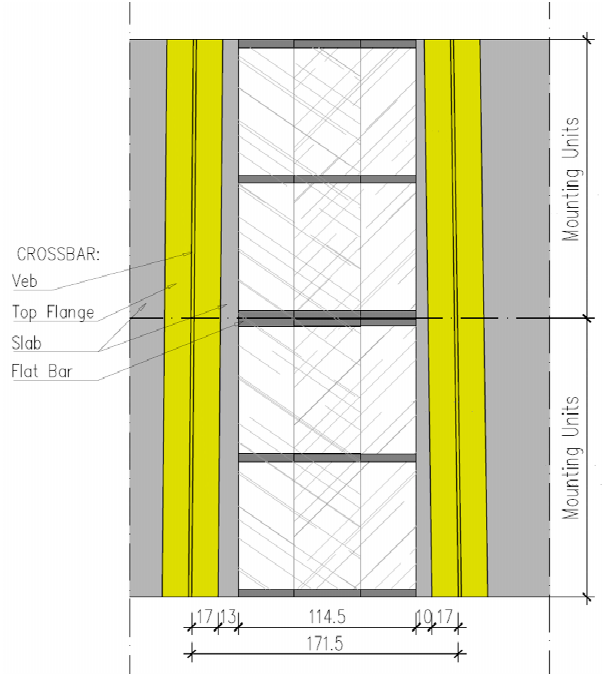
Figure 5. View from the underside of the expansion joint on two modules (mounting units) of the sound cover.